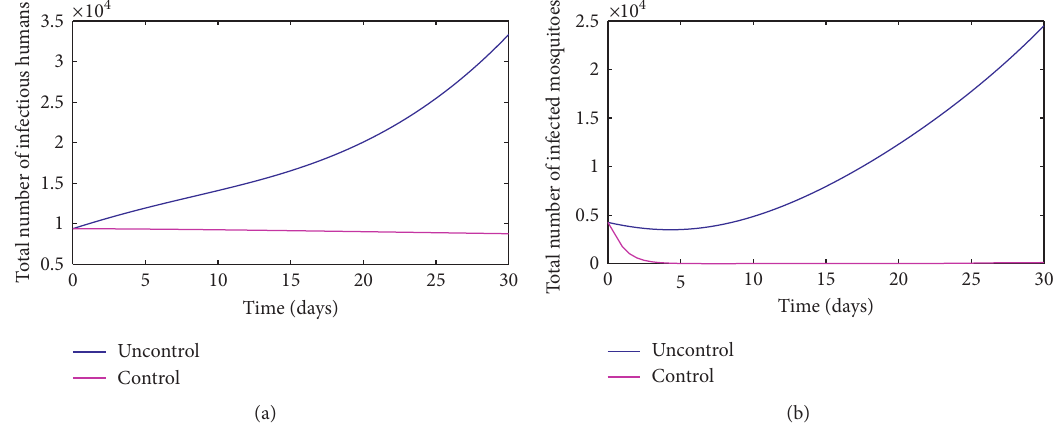
Figure 2: Simulation results of model (15) with and without controls using the maximum mean temperature of 25 . 32 ° C in KwaZulu-Natal, South Africa. (a) Infectious individuals. (b) Infectious mosquitoes.